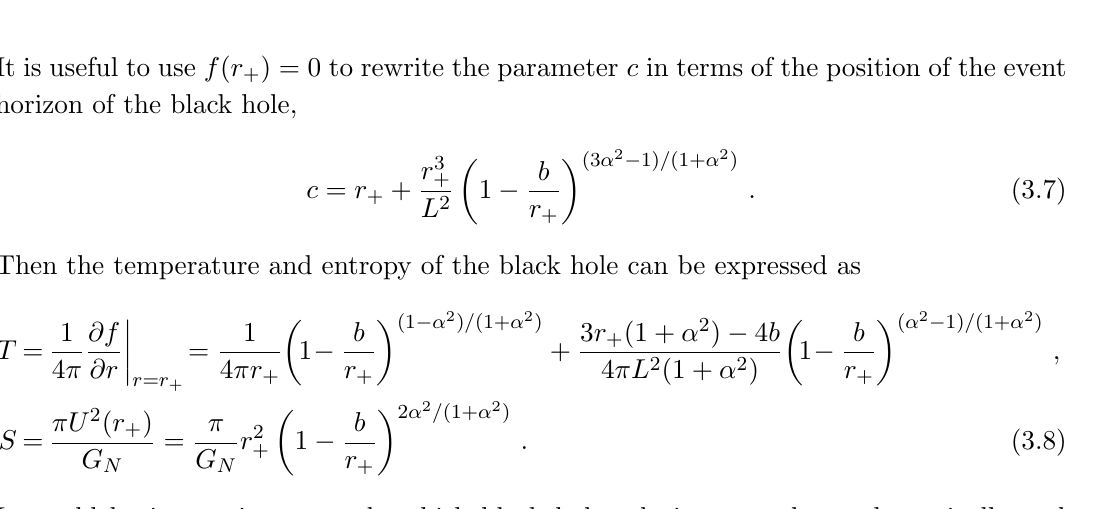
Figure 6 . Causal structure for the charged dilatonic black hole given by eq. (3.4). The left panel corresponds to (cid:11) 2 (cid:21) 1 = 3, for which the causal structure is similar to that of the Schwarzschild-AdS black hole, with a spacelike singularity at r = b . The right panel corresponds to 0 (cid:20) (cid:11) 2 < 1 = 3, for which the causal structure is similar to that of the Reissner-Nordstrom-AdS black hole and the timelike singularity lies behind an inner Cauchy horizon (at r = r (cid:0)